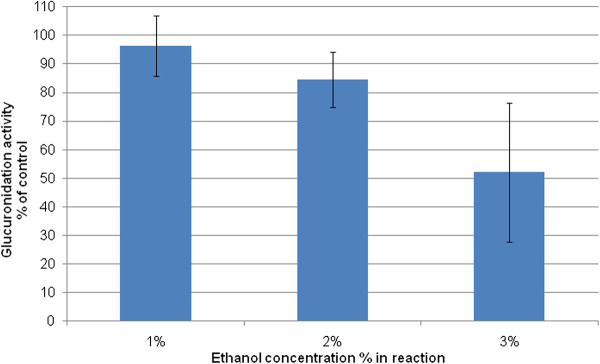
Effect of ethanol on the testosterone glucuronidation by UGT2B17, based on the concentration of testosterone. Concentration of testosterone was measured at the end of the reaction which was terminated after 30 minutes. The results display the SD values of duplicate samples.